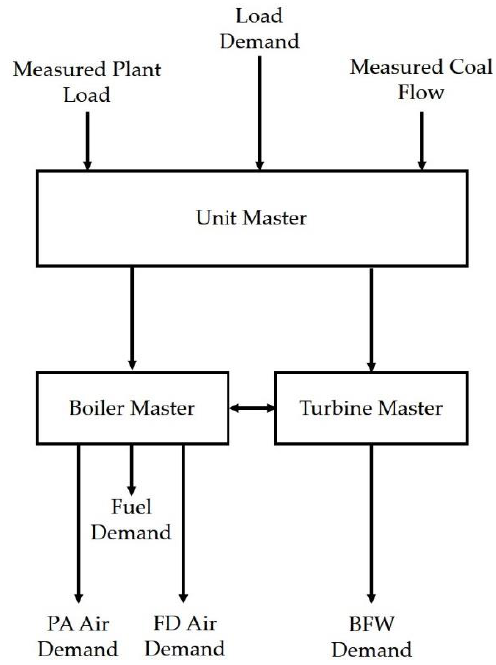
Figure 4. Coordinated Control System (CCS) Master Diagram.